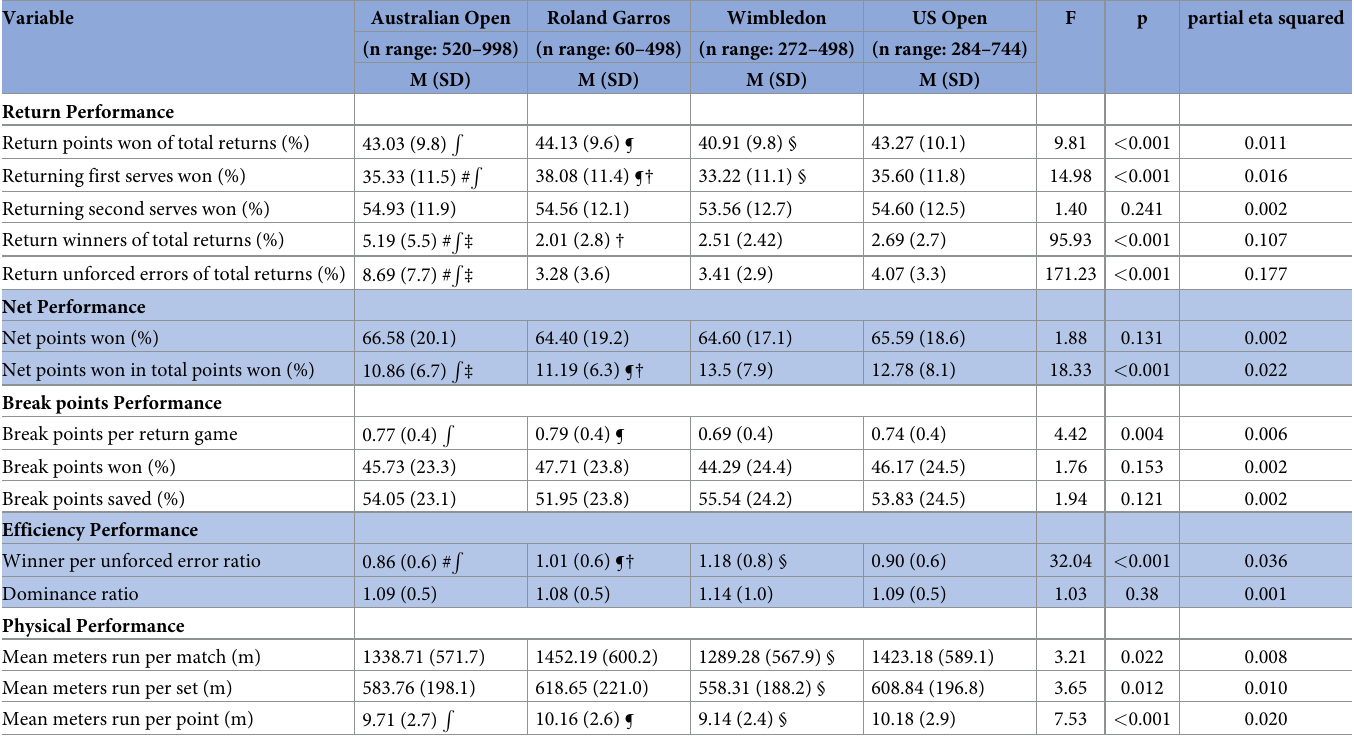
Table 2. Return, net, break point, efficiency and physical performance of female players in four Grand